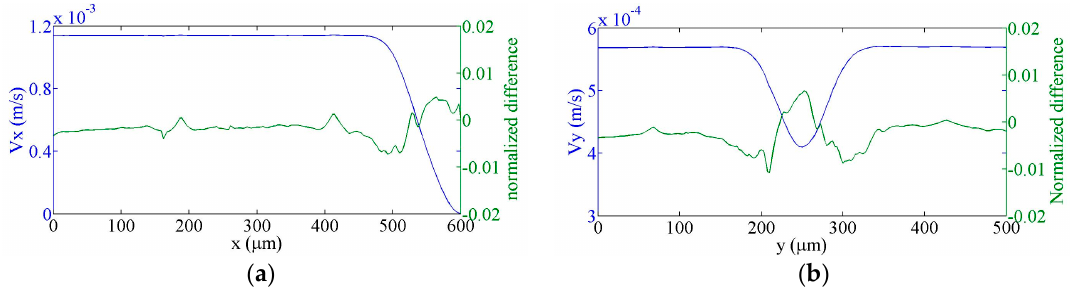
Figure 6. Q3D calculated values of flow velocity and their normalized differences from COMSOL calculations, ( a ) along the centre of the input channel, ( b ) along the centre of the output channels (absolute velocity values).